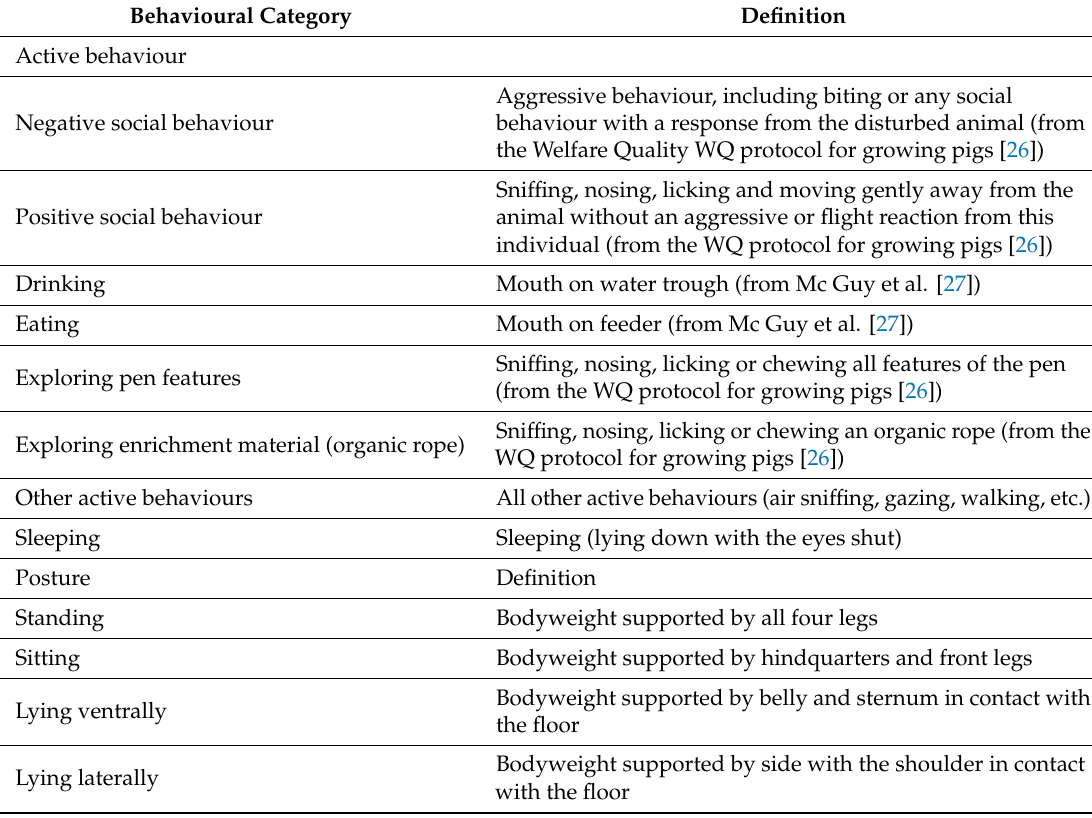
Table 1. Description of behavioural variables and postures assessed during direct observations (scan sampling) at 24 h pre- and